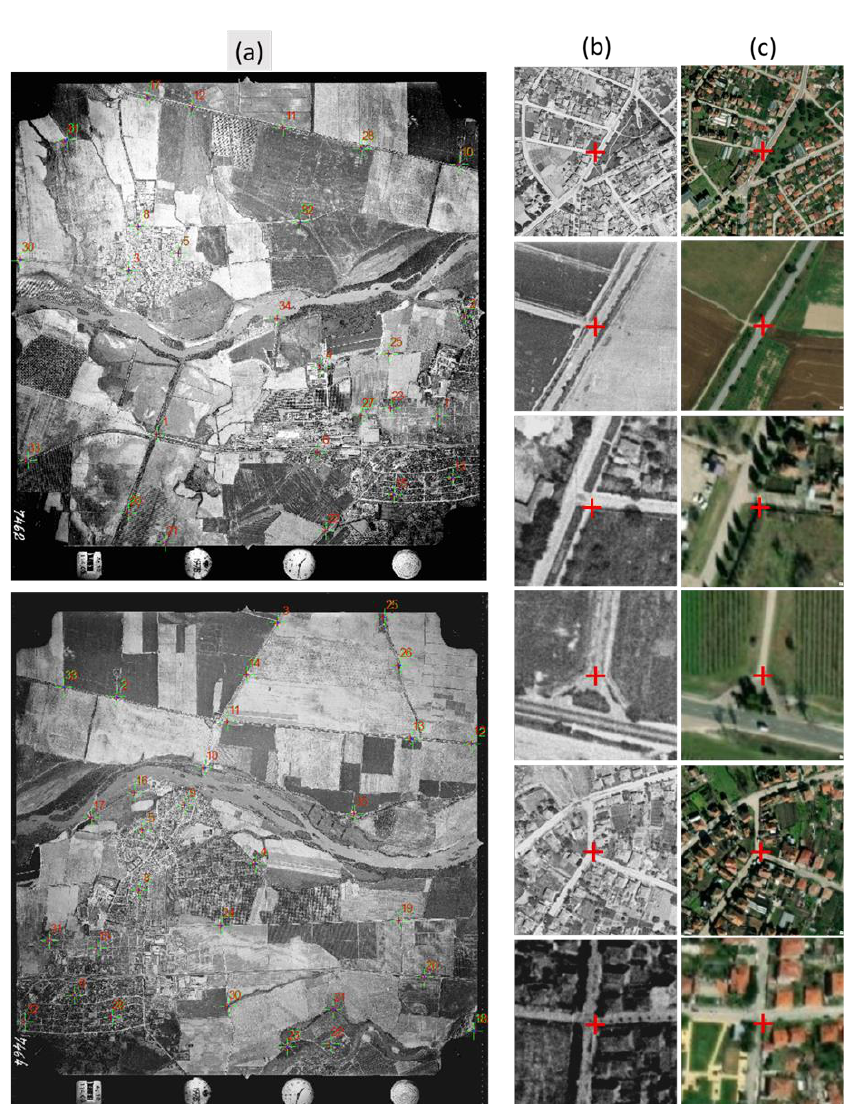
Figure 6. ( a ) Distribution of GCPs on two aerial photographs of Stamboliyski from 1975 and examples of GCPs selection (red crosses) on ( b ) aerial photographs and their counterparts on ( c ) Google Earth image.